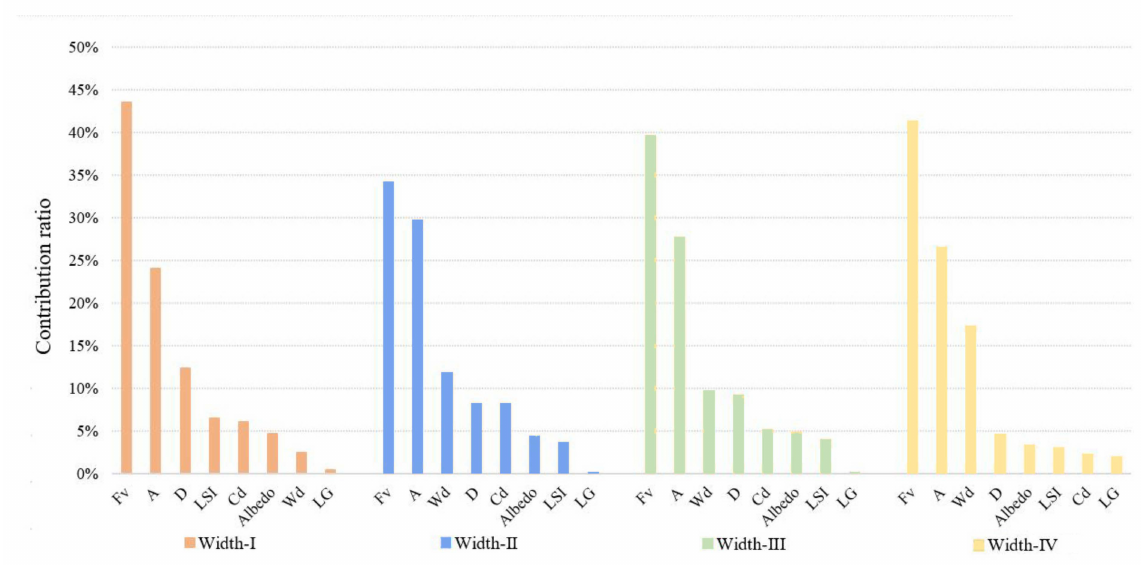
Figure 22. Contribution ratios of each spatial variable to the LST in rivers with different width